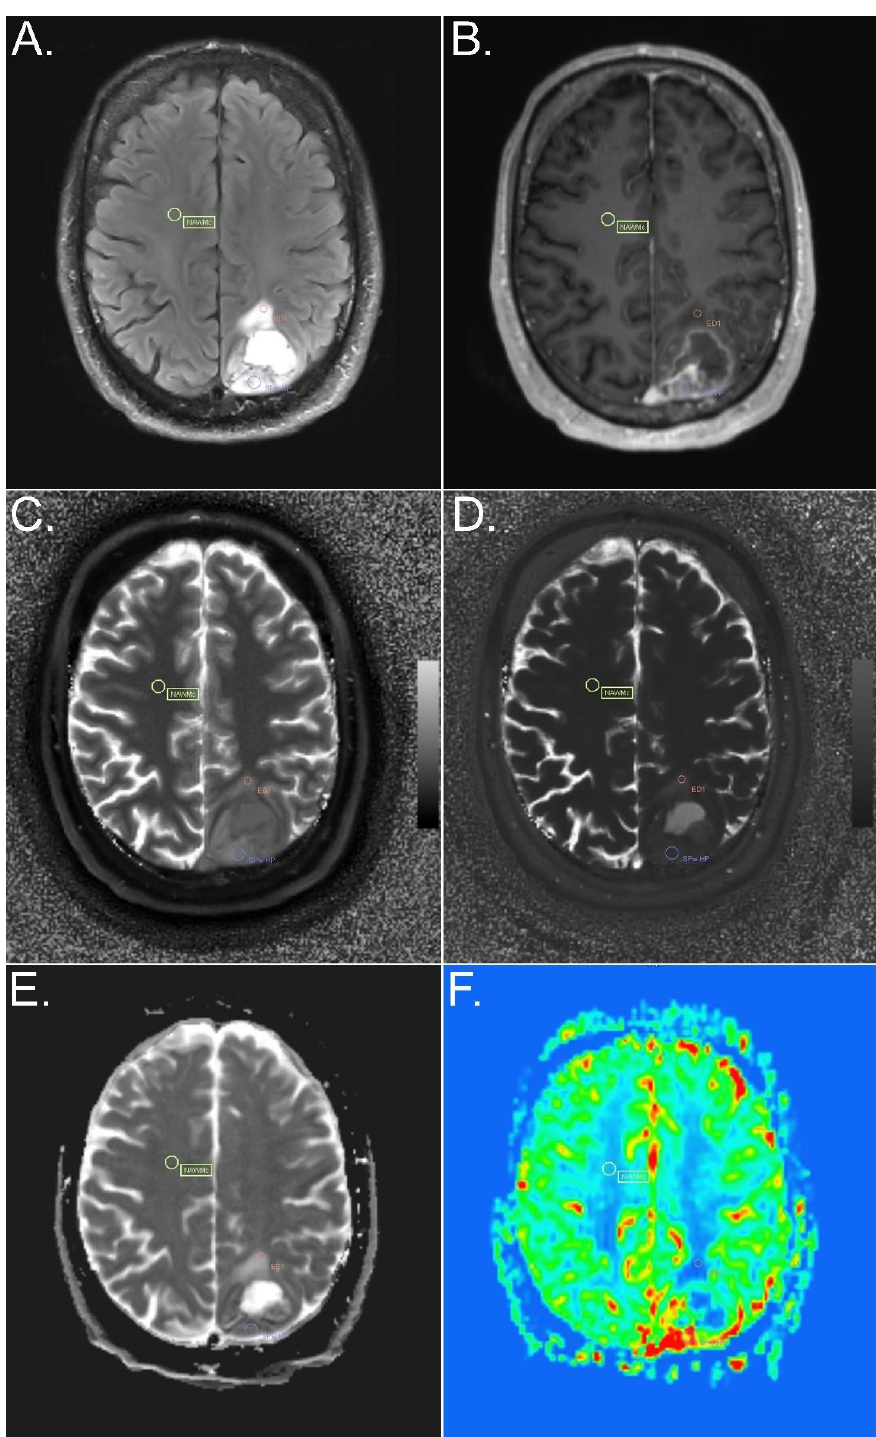
Figure 2. Example of ROI placement in different tumor components of a glioblastoma, IDH-wildtype. FLAIR ( A ), T1-weighted MPR post i.v. contrast administration ( B ), MRF T1 ( C ) and T2 ( D ) maps, ADC map ( E ), and perfusion-weighted imaging ( F ). ROIs were placed in the solid tumor part, in an area with contrast enhancement and an rCBV increase (violet circle), in peritumoral edema (red circle), and in contralateral NAWM (yellow circle). SPw HP, solid part of the tumor with contrast enhancement and with hyperperfusion; ED1, peritumoral edema less than or equal to 1 cm distant from the tumor; NAWMc, contralateral NAWM of the frontal